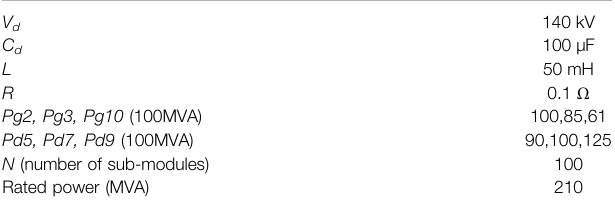
TABLE 1 | Important parameters of grid and MMC.